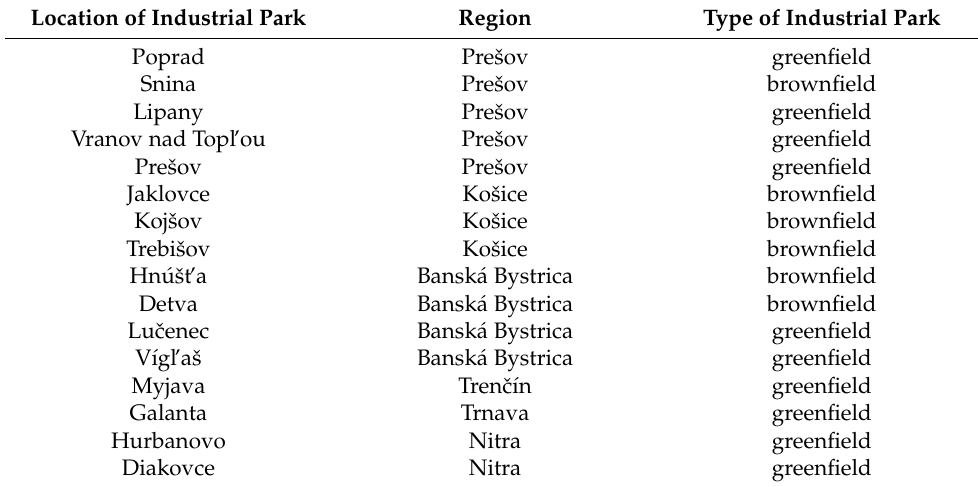
Table 4. Supported investment projects of industrial parks in Slovakia [63]. Location of Industrial Park Region Type of Industrial Park Poprad Prešov